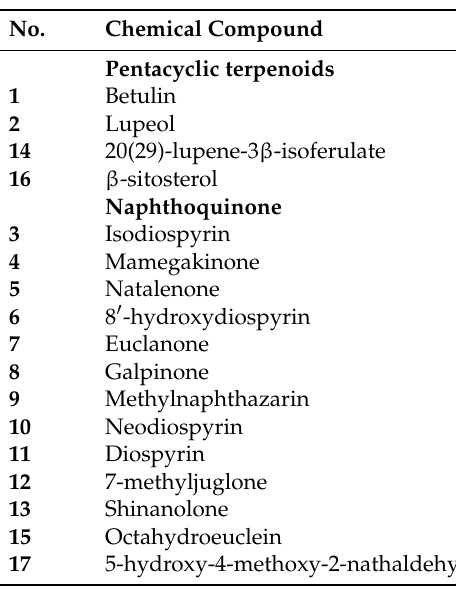
Table 2. Chemical compounds isolated and characterized from Euclea natalensis root